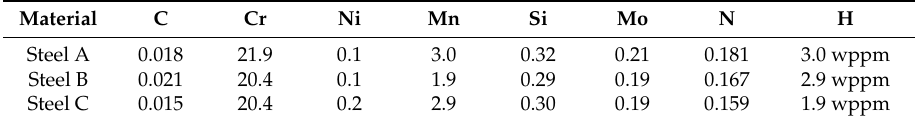
Table 4. Chemical composition of the studied